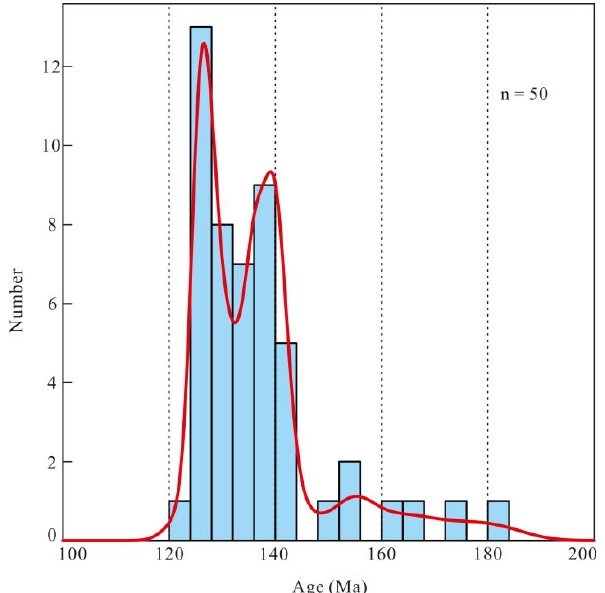
Figure 8. Zircon ages for granitoids in the central-southern Great Xing’an Range and adjacent areas (ages data cited from Supplementary Table S4).